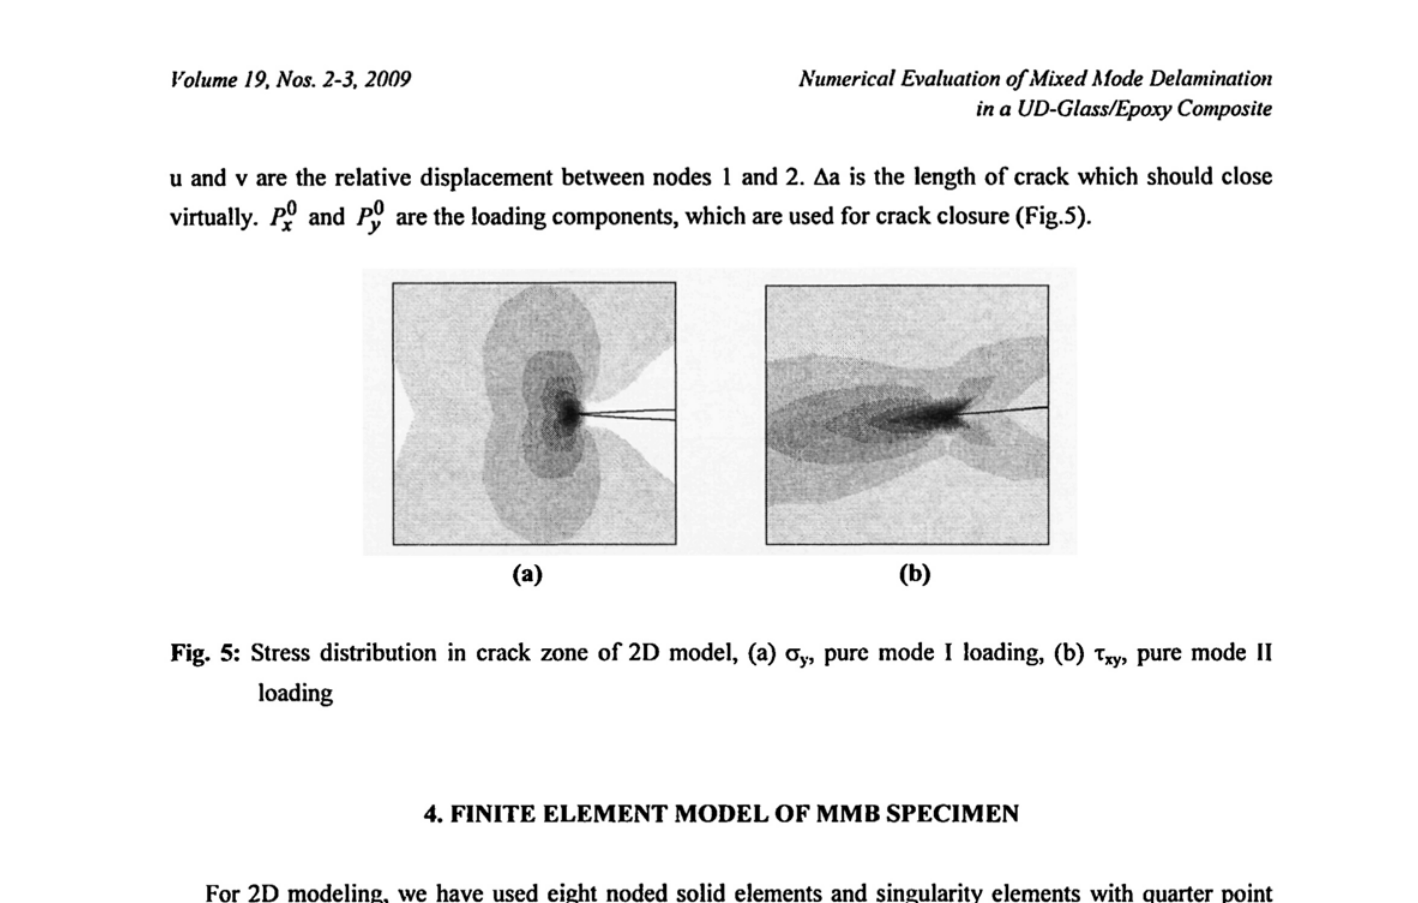
Fig. 5: Stress distribution in crack zone of 2D model, (a) a loading